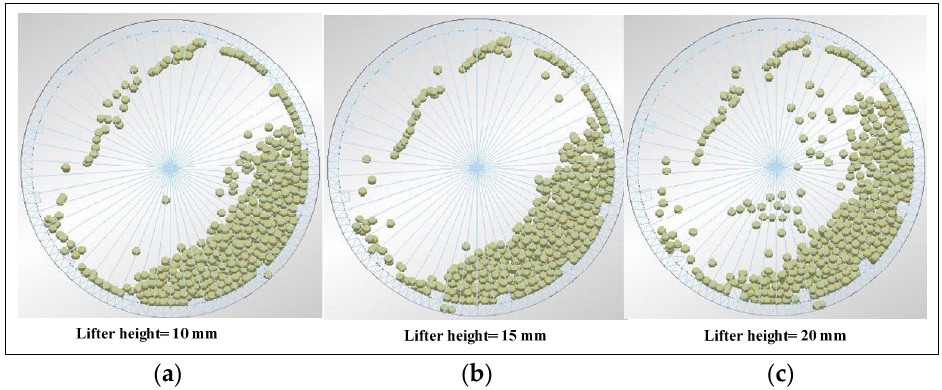
Figure 11. Photograph of the impact load behavior with different lifter height: ( a ) 10 mm; ( b ) 15 mm; and ( c ) 20 mm.